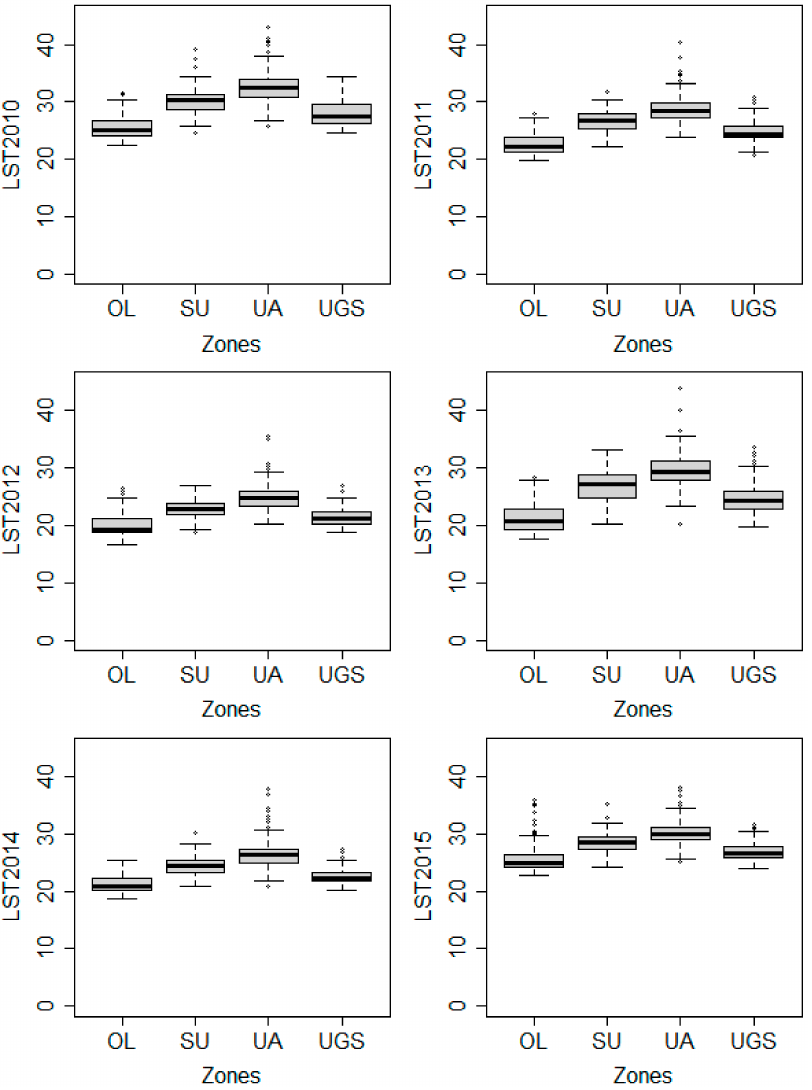
Figure 8. Comparison of boxplots of LST distributions for random points within the analyzed zones in the years 2010–2015. Boxes indicate median and quartiles, and whiskers extend to the most extreme data points, not considering outliers (defined by 1.5 interquartile ranges). OL—open land, UA—dense urban area, SU—discontinuous urban area, UGS—urban green